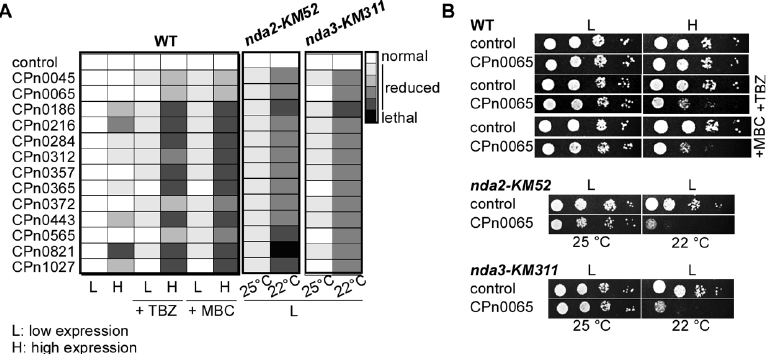
Figure 3. Expression of all 13 Cpn proteins in yeast resulted in MT hypersensitivity and synthetic lethality with tubulin mutants. ( A ) Growth phenotypes of S. pombe transformants that expressed one of the indicated 13 Cpn genes (systematic names on the left). The severity of the growth defect is indicated by the shades of the box (the darker, the more severe). The strains analyzed were the wild-type (WT) and the cold-sensitive nda2-KM52 and nda3-KM311 mutant strains. Media was with TBZ or MBC if indicated. Growth of WT was undertaken for 5 days at 25 ◦ C. The tubulin mutant strains grew for six days at the indicated temperatures. Top panel in ( B ): S. pombe serial dilution patch tests (10 4 –10 1 cells) of cpn0065 -expressing WT cells grown under plasmid-selective conditions at 25 ◦ C for 6 days without or with either 7 µ g/mL TBZ or 2.5 µ g/mL MBC; L: low expression, H: high expression. Middle and bottom panels: serial dilution patch tests of cold-sensitive nda2-KM52 and nda3-KM311 transformants that expressed cpn0065 incubated at 25 ◦ C or 22 ◦ C for 6 days; L: low